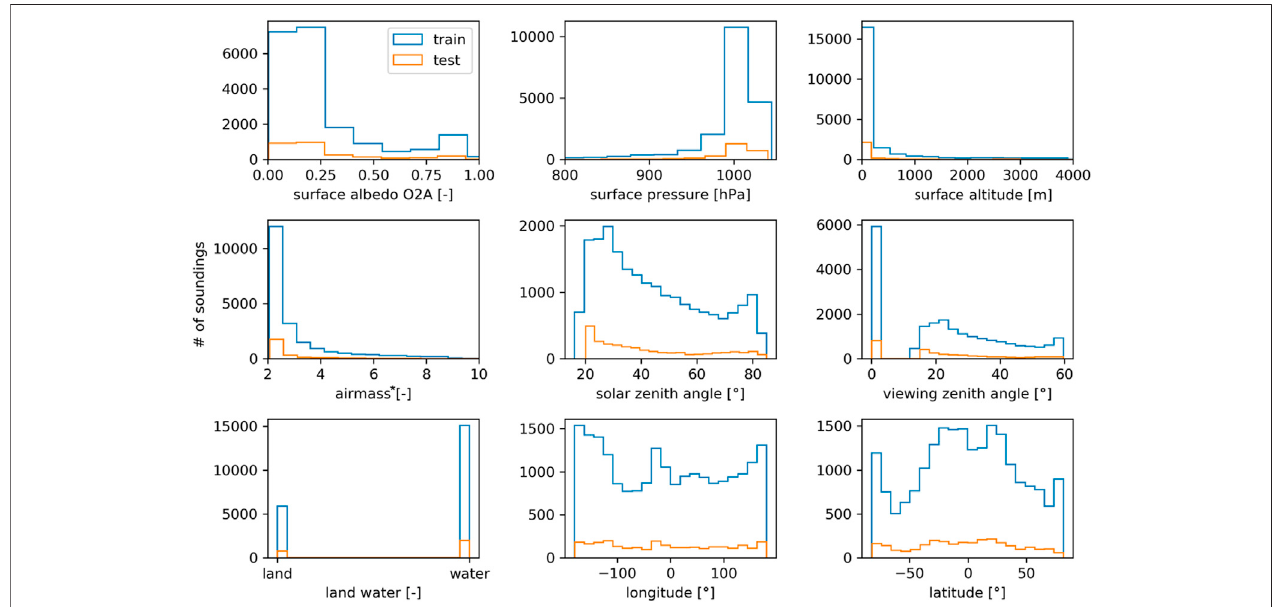
FIGURE 1 | Distribution of subset of state variables from OCO-2 soundings used in this study. Training set is shown in blue, Testing set in orange. *Airmass describes the relative airmass of a sounding de fi ned as 1/cos (solar zenith angle) + 1/cos (viewing zenith angle).